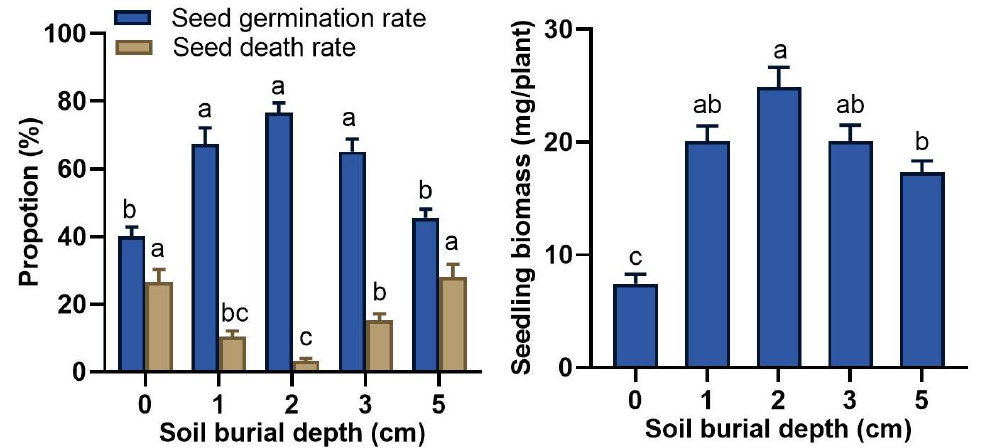
Figure 1. Effect of burial depth on seed germination rate, seed death rate and seedling biomass of Caragana stenophylla (mean ± SE). Different lowercase letters indicate significant differences among treatments, p < 0.05, Tukey HSD.